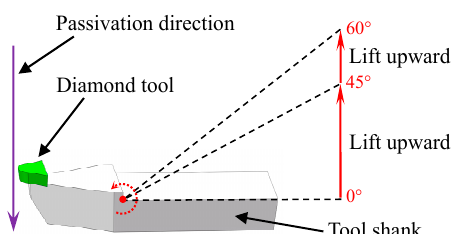
Figure 5. The curve of true stress vs. true strain for KDP crystal in SPH simulations [46].